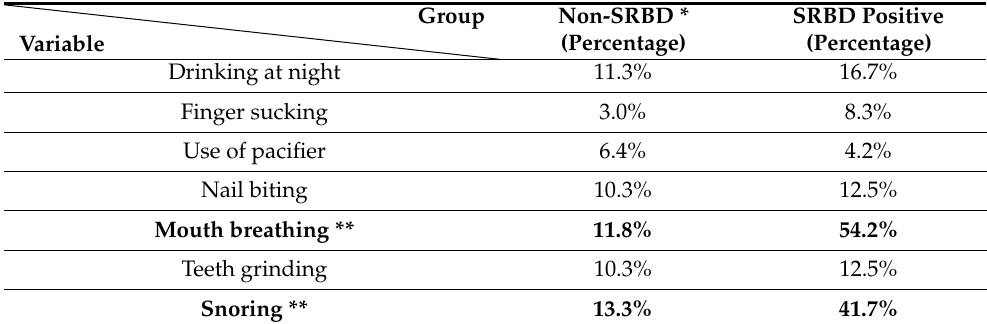
Table 3. Children oral behaviors and